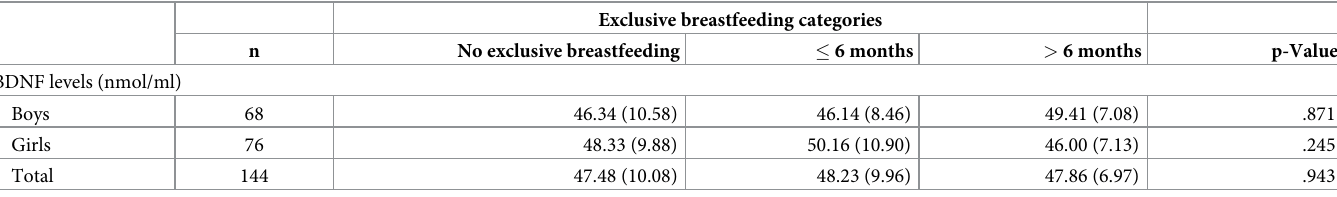
Table 2. Mean difference in BDNF levels by exclusive breastfeeding categories and sex.